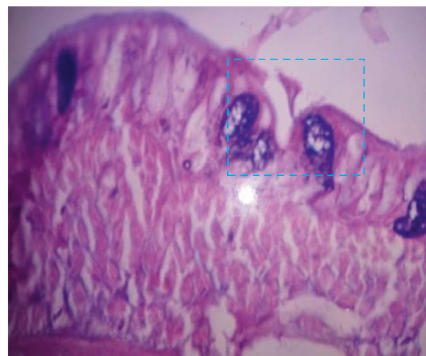
Figure 3: A longitudinal section of the body wall of worms exposed to 50 ppm concentration showing cuticle rupture and cell shrinkage (H and E) magnification 400.